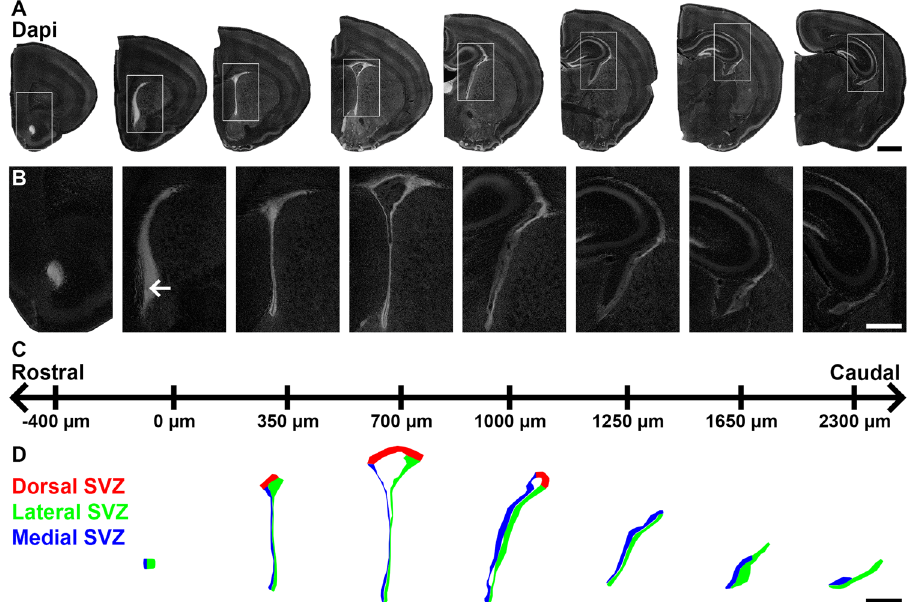
Figure 1. Definition of SVZ microdomains throughout the rostro-caudal LV coordinates. (A) Representative mosaics of P10 coronal sections counterstained with Dapi at various rostro-caudal coordinates (indicated in C). (B) Higher magnification micrographs showing the rostro-caudal extension of the open LV from its first rostral appearance (arrow) to its more caudal coordinates. (C) Coordinates used in this study. The coordinate “0” is defined as the first appearance of the opened LV. (D) Schematic representation of the opened LV at various rostro-caudal coordinates. The dorsal (red), lateral (green) and medial (blue) microdomains are indicated. Scale bars: (A) = 1 mm; (B,C) = 500 µ m. Abbreviations: SVZ, subventricular zone; LV, lateral